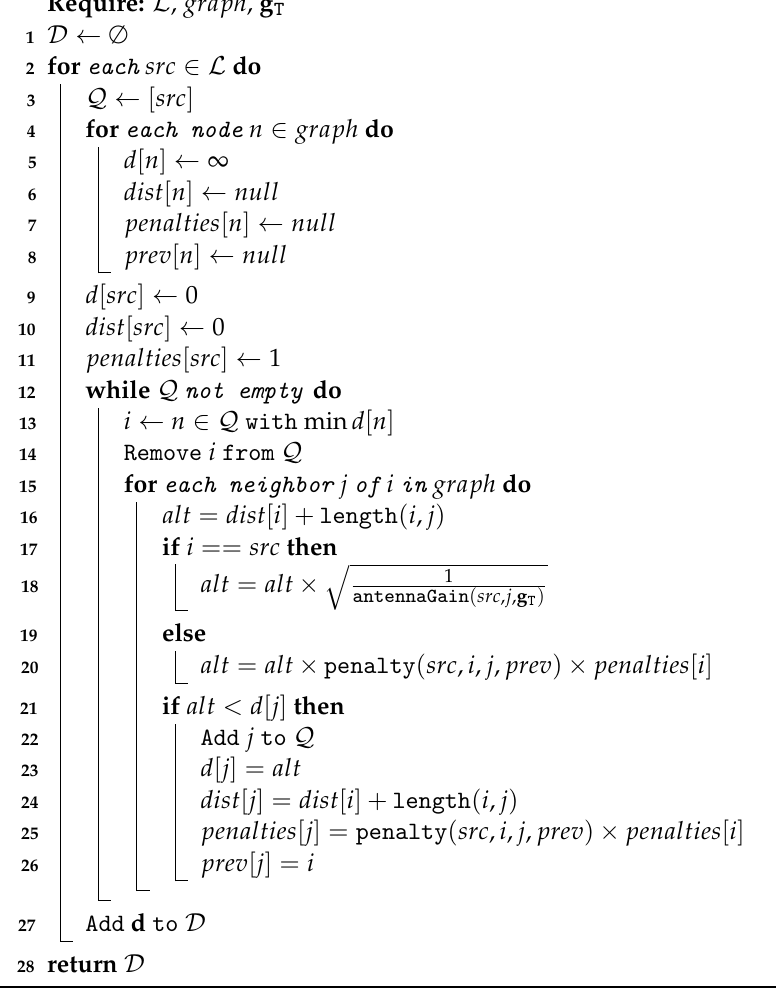
Algorithm A1: The algorithm for searching paths.